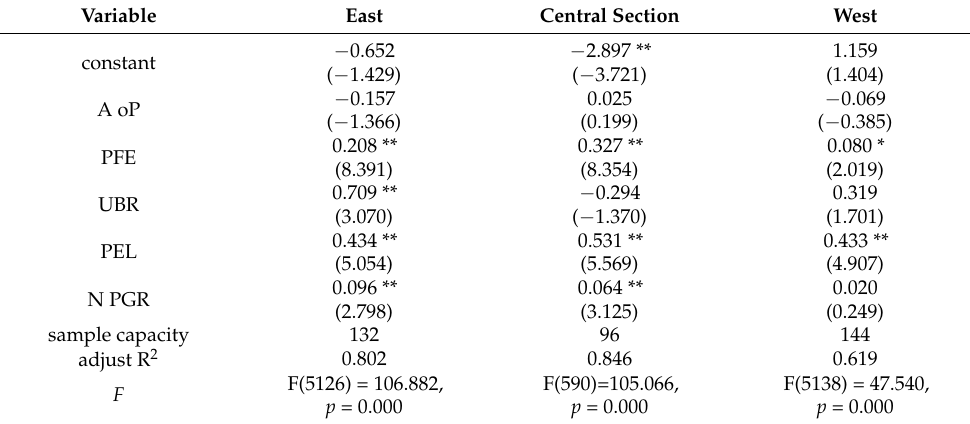
Table 9. Sub-sample regression results of the intermediary effect of pension